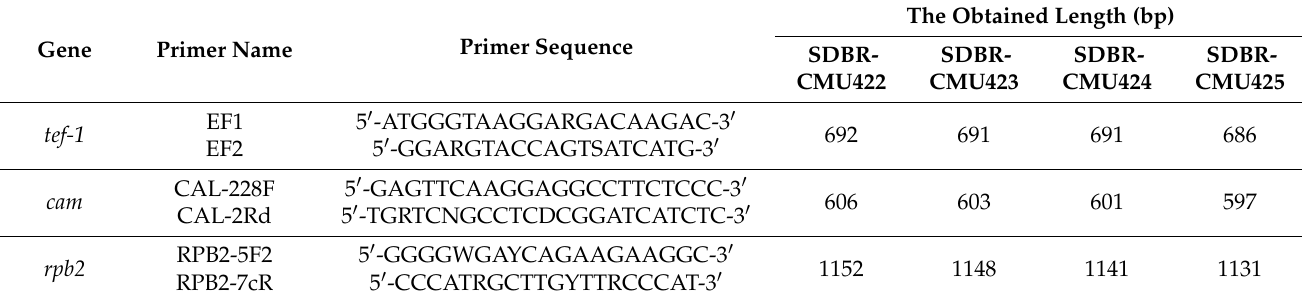
Table 1. Details of primers and the obtained PCR product in this